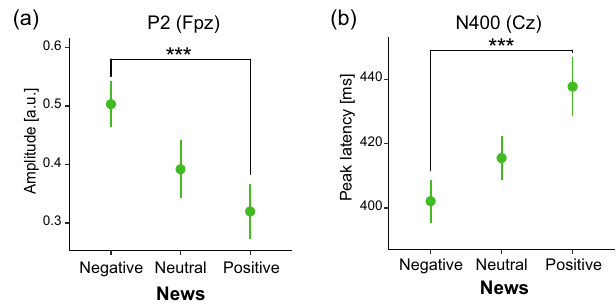
Figure 4. Main effect of News on EEG. ( a ) The P2 amplitude at the Fpz was larger for the negative news than for the positive news. ( b ) The peak latency for N400 for negative news at the Cz was shorter than that for positive news. Each circle and error bar represent the mean and standard error, respectively. *** p <